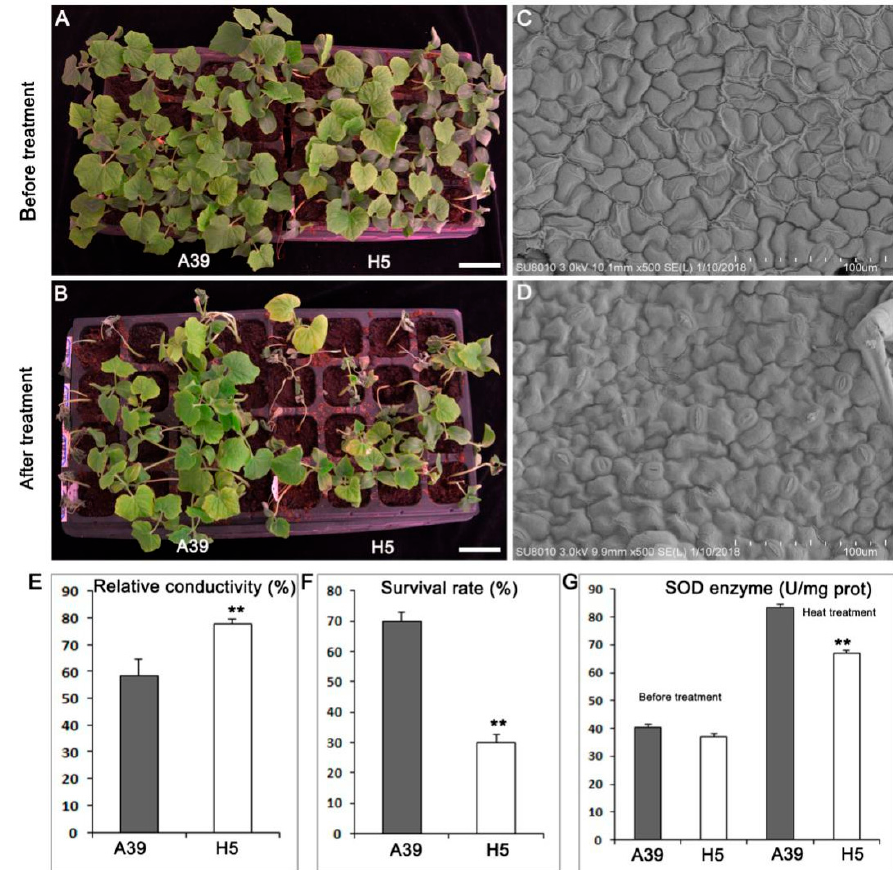
Figure 1. Phenotypes of A39 and H5 after four days heat stress. ( A ) A39 and H5 plants were grown under normal condition for 14 days. ( B ) Seedlings were watered and grew under normal conditions for three days. ( C , D ) Scanning electron microscopy (SEM) images of leaves in A39 ( C ) and H5 ( D ). ( E ) Detection of relative conductivity of A39 and H5. ( F ) The survival rate of plants of A39 and H5 following the four days heat treatment. ( G ) Measurement of superoxide dismutase (SOD) enzyme activity under normal condition and four days after heat stress. Data are presented as the mean ± standard deviation ( n = 9). ** p < 0.01; Student’s t -test.